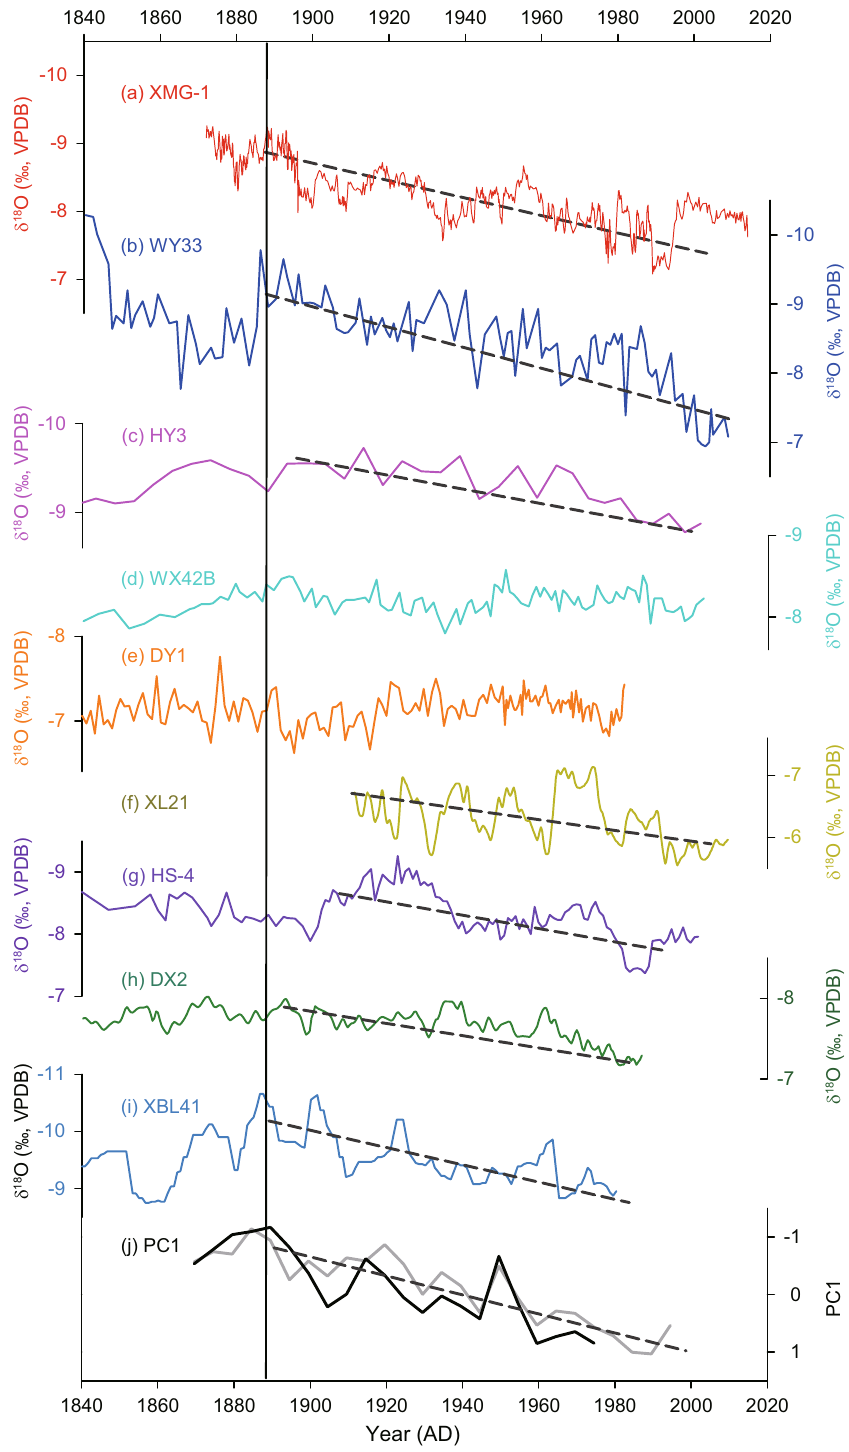
Figure 3. Comparison between Chinese stalagmite δ 18 O records since 1840 AD. ( a ) to ( i ) are Shihua Cave (red, this study), Wuya Cave (blue) 25 , Huangye Cave (pink) 28 , Wanxiang Cave (Cyan) 29 , Dayu Cave (orange) 26 , Xianglong Cave (dark yellow) 32 , Heshang Cave (purple) 35 , Dongge Cave (green) 37 , and Xiaobailong Cave (sky blue) 27 δ 18 O records, respectively. ( j ) shows two PC1 components (black, integrated from ( a )–( e ) and ( g )–( i ) records during 1875–1980 AD; gray, integrated from ( a )–( d ) and ( g ) records during 1875–2000 AD). The vertical line indicates the approximate beginning timing of increasing trend in these records identified by PC1 components (accounting for ~40% of the total variance), and the dark gray dashed lines depict the increasing trend in each record, except for WX42B and DY3 records which did not show a statistically significant trend since the